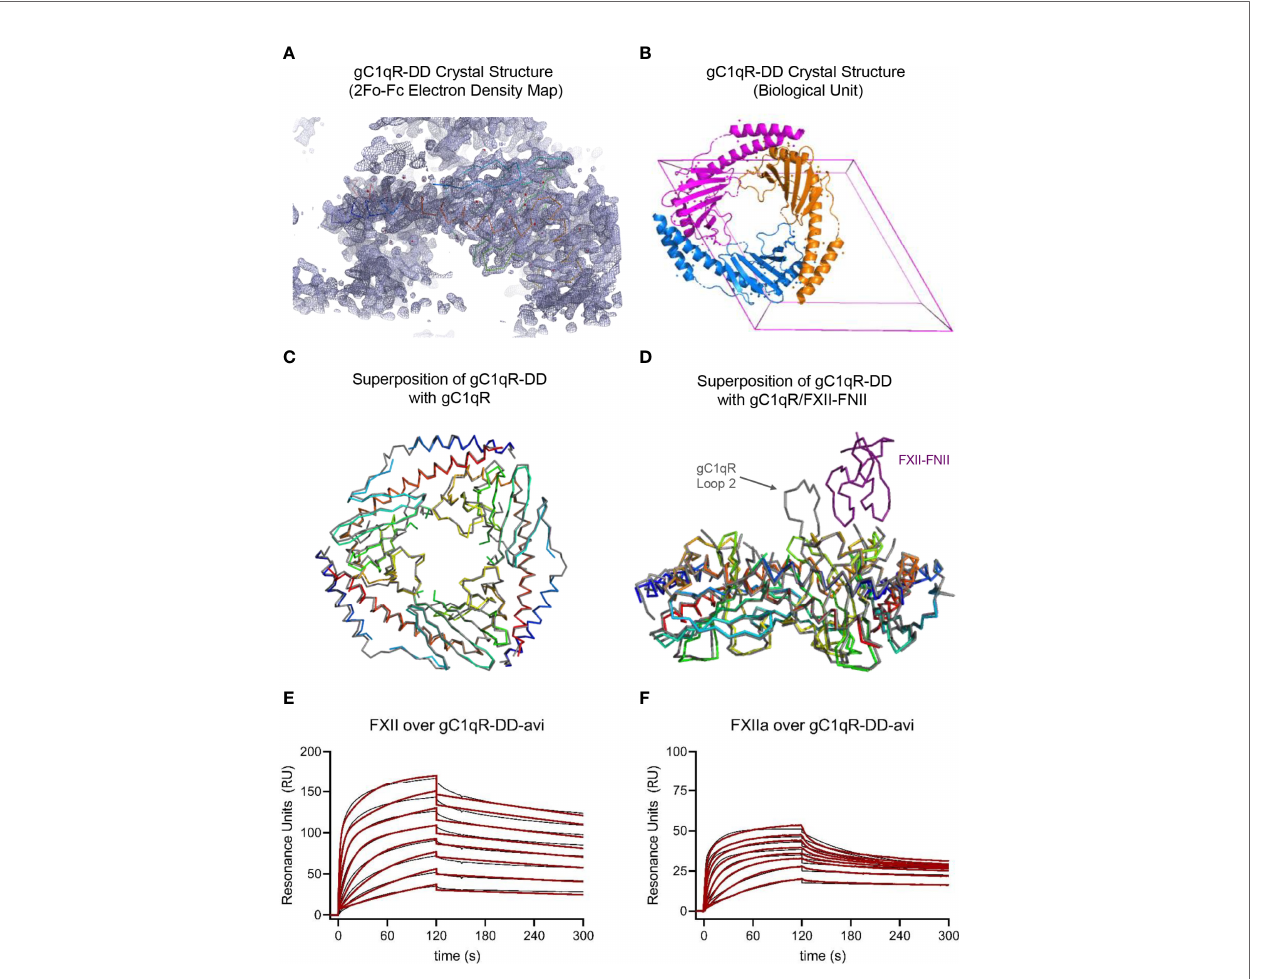
FIGURE 2 | Crystal Structure and Functional Studies of the gC1qR-DD Mutant. (A) Correlation of the 2Fo-Fc electron density map contoured at 1.3 s (grey mesh) with the C a position of the fi nal model (rainbow wire, with N-terminus in blue and C-terminus in red) for the structure of gC1qR-DD determined at 2.2 Å resolution. The U-shaped void at the bottom of this image represents the hole formed upon trimerization of gC1qR-DD monomers. (B) Visualization of the gC1qR-DD trimer constructed by applying the crystallographic symmetry operators of the P6 3 22 unit cell (pink box). Individual polypeptides are shown as ribbon diagrams using distinct colors. (C) Structural superposition of the gC1qR-DD trimer (rainbow wires) with that of wild-type gC1qR (grey wire). Structures are represented by their C a positions only for clarity. Coordinates for wild-type gC1qR were obtained from PDB entry 1P32 (9). (D) Structural superposition of the gC1qR-DD trimer (rainbow wires) with that of wild-type gC1qR (grey wire) bound to the FNII domain of FXII (purple wire). Structures are represented by their C a positions only for clarity. Coordinates for wild-type gC1qR bound to FXII-FNII were obtained from PDB entry 6SZW (11). Note that acidic loop 2 contributes a major binding determinant for FXII-FNII (11). (E) gC1qR-DD was enzymatically biotinylated through a C-terminal avi-tag and captured to a density of ~100 RU on two experimental fl ow cells of a streptavidin-derivatized sensor chip. Dose-response sensorgrams for injection of a two-fold dilution series of FXII (800 nM highest concentration) over gC1qR-DD-avi. The black trace represents the experimental data, while the red line represents the outcome of fi tting to a ligand heterogeneity kinetic model. (F) An identical experiment to that shown in panel (E) , with the exception that solutions of FXIIa were used as the analytes (800 nM highest